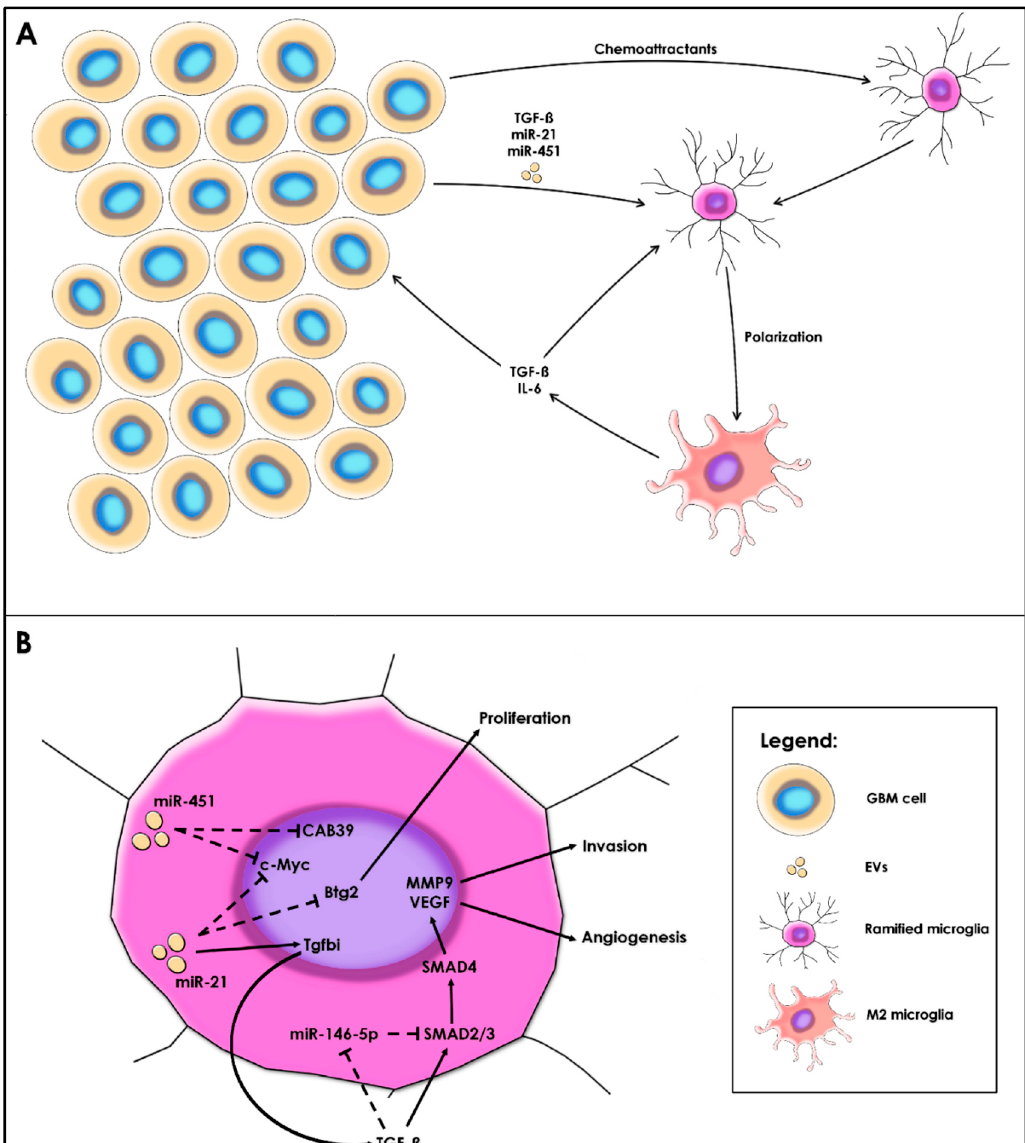
Figure 4. ( A ) Microglia recruitment and M2 polarization under the influence of soluble factors and miRNAs from GBM cells. ( B ) miR-21, miR-451, and miR-146-5p roles in the activation of microglia (arrows—activation; dotted T-bars—inhibitory effect).